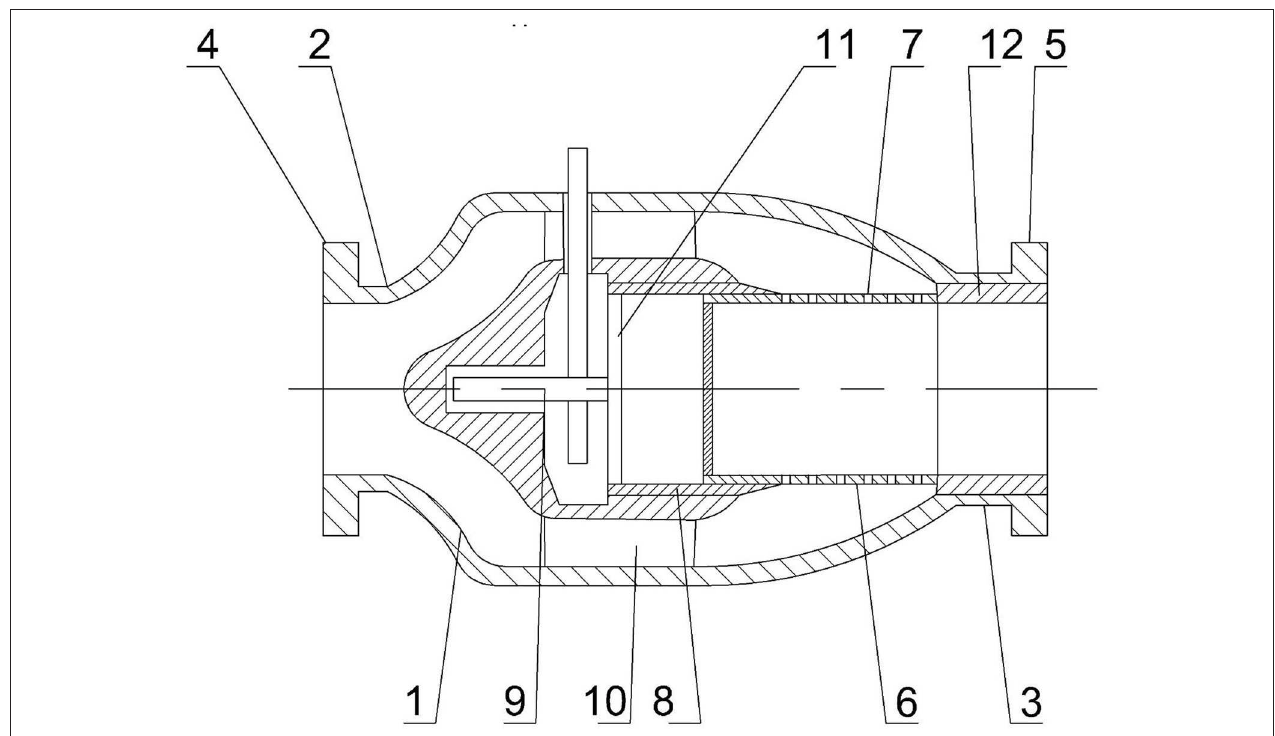
FIGURE 1 | Schematic diagram of an axial valve with an external positioning of the locking member: 1–outer case, 2 and 3–inlet and outlet nozzles, 4 and 5–flanges, 6–separator, 7–throttle holes, 8–cylindrical conical (external locking shell), 9–rack and pinion mechanism, 10–cavity of the inner housing, 11–radial partitions, 12–expansion